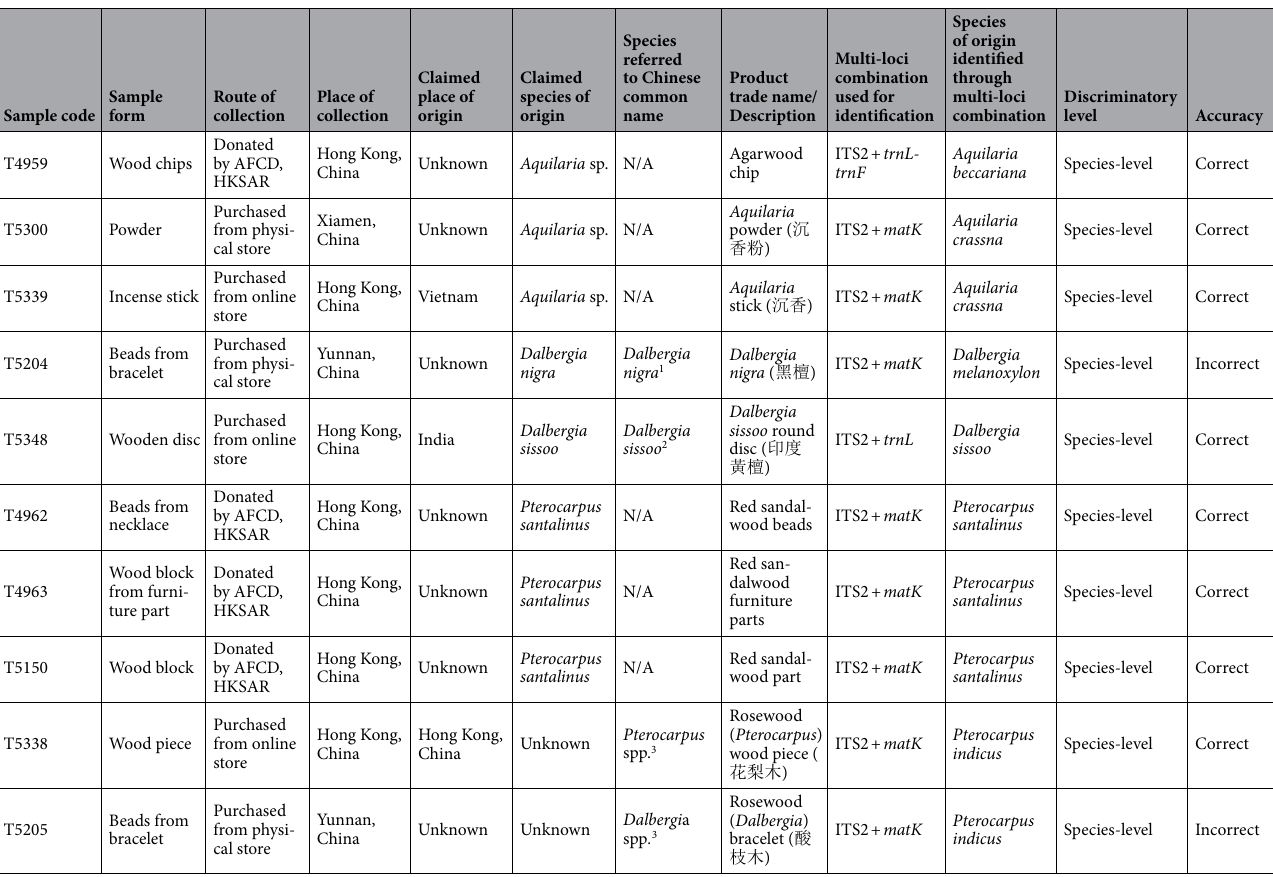
Time consumed in this method was approximately within 4 h for 24 samples and each sample costed USD 13.5. DNA quantity and quality analysis. For comparison of DNA extracted using the three genomic DNA extraction methods, the quality and quantity of the DNA extracted were evaluated by a NanoDrop Lite spectro- photometer (Thermo Scientific, Massachusetts, USA). PCR amplification, agarose gel electrophoresis and DNA sequencing. For each genus, differ- ent DNA mini-barcode loci were selected for amplification and sequencing based on their species discrimina- tion ability evaluated by previous research. For Aquilaria , DNA barcode loci ITS2, matK and trnL - trnF were selected 20 . For Dalberiga , DNA barcode loci ITS2, matK , trnH - psbA and trnL were selected 18 and for Pterocar- pus , DNA barcode loci ITS2, matK , rbcL and ndhF - rpl32 were selected 19 . DNA extracted were amplified using the GoTaq G2 Flexi DNA Polymerase (Promega, Wisconsin, USA). Each 15-μL PCR contained 10 ng template